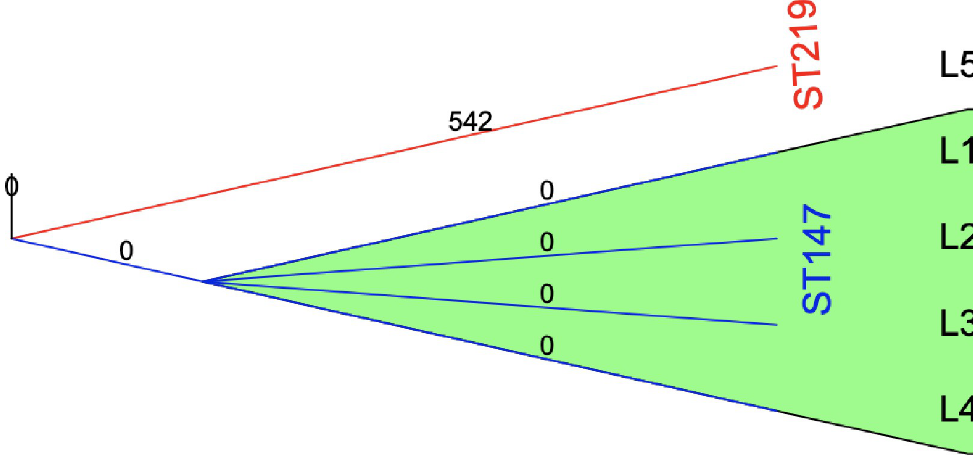
Fig 2. Minimum spanning tree constructed based on the dynamic core genome (cgMLST) of the K . pneumoniae isolates. The bla NDM-1 encoding ST147 isolates were clonally clustered (L1-L4, green shaded) and no allelic differences were detected.